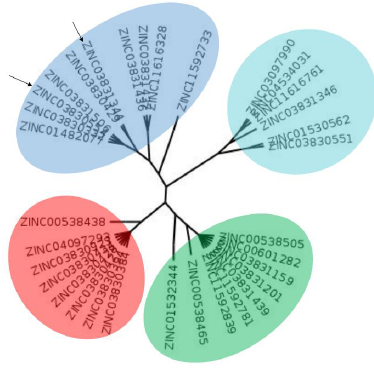
Figure 2. Clustering pattern based on ligand contact amino acid showing the four major groups. In cyan, group 1, in blue, group 2, in red, group 3, and in green, group 4. Arrows indicate the compound ZINC03830554 and ZINC03831344 mentioned in the text.